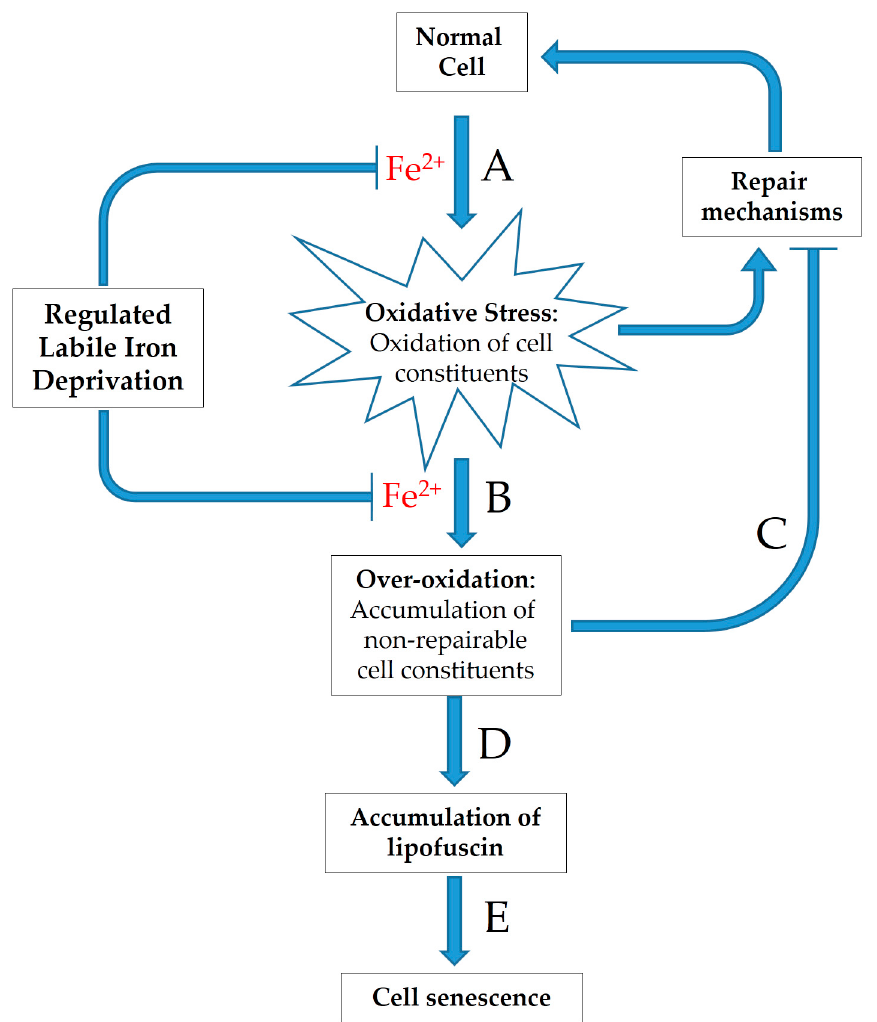
Figure 2. Schematic representation of sequential steps that lead to lipofuscin formation and contribute to cellular ageing. Note that Fe 2+ is required for the generation of highly reactive ROS (HO • and RO • ), which are responsible for the oxidation and over-oxidation of cellular macromolecules (A,B). Over-oxidized macromolecules can inhibit cellular repair systems (especially 20S proteasome), thus facilitating futile cycles of progressively increasing oxidation rates (C). Oxidatively modified, non-degradable cellular components are gradually accumulated into cells as covalently interconnected aggregates in the form of lipofuscin (D), a fact that is proposed to influence the process of cell ageing (E). Arrowheads and flatheads indicate the induction and inhibition, respectively, of processes.